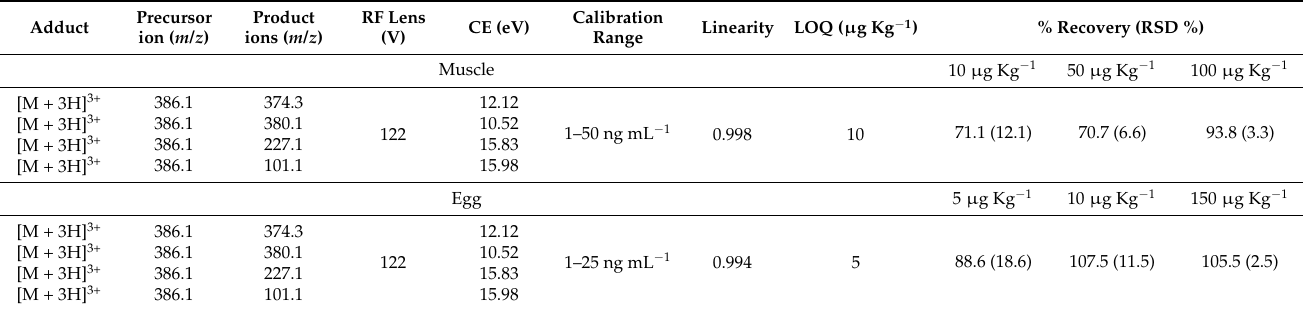
Figure 1. The full MS ( A ) and MS/MS spectra ( B ), and fragmented structures ( C ) for colistin B. Table 2. Ultra-high-performance liquid chromatography–tandem mass spectrometry (UHPLC–MS/MS) parameters for colistin B and its validation results in chicken muscle and egg.